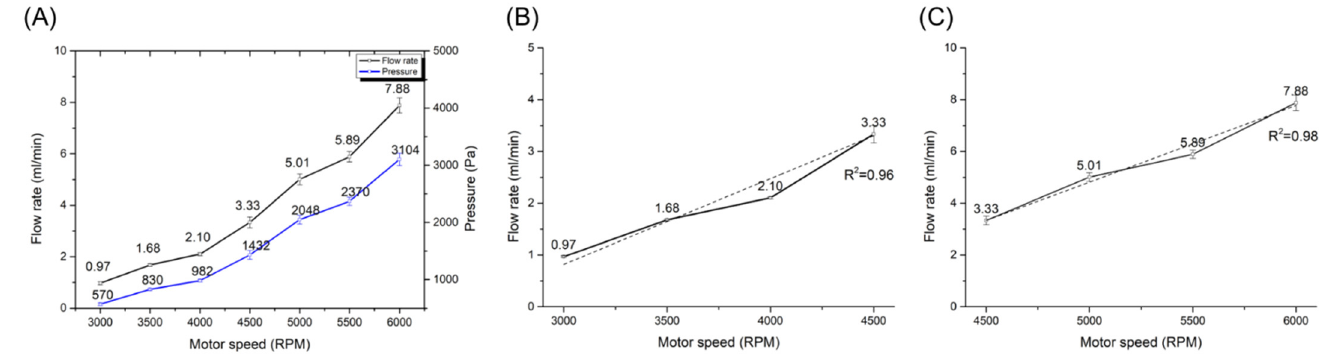
Figure 6. Pressure and flow rate curves of the glass micropump depending on the motor speed. ( A ) 3000–6000 RPM, ( B ) 3000–4500 RPM, ( C ) 4500–6000 RPM. In ( A ), blue and black lines are pressure and flow rate curves, respectively. In ( B , C ), the solid and the dotted line represent flow rate curve and flow rate trends, respectively.